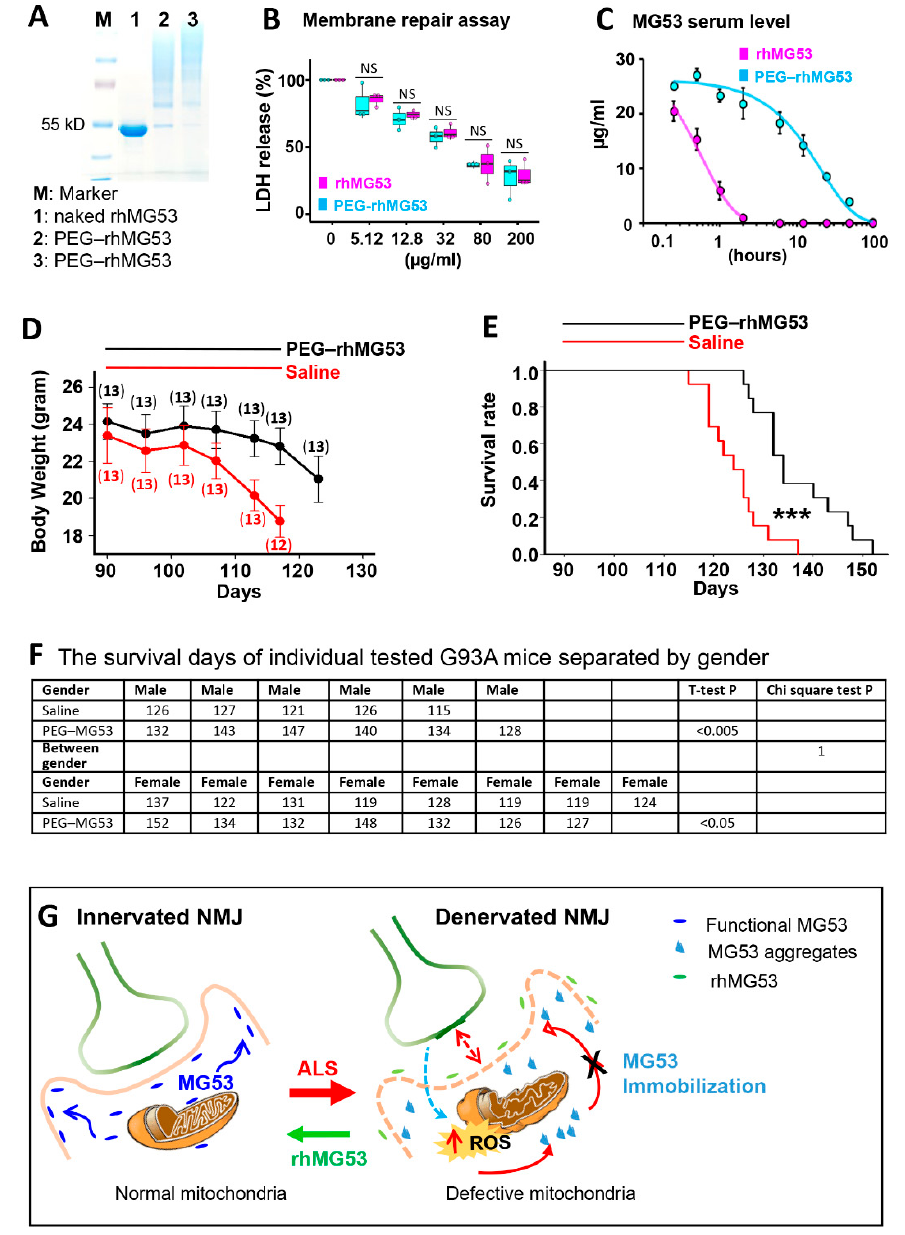
Figure 8. rhMG53 alleviates disease progression and extends the life span of G93A mice. ( A ) PEGyla- tion of rhMG53 is successful based on Coomassie blue staining of the different oligomerization pat- terns of the protein running on SDS–PAGE. Lanes 2 and 3 represent two independent rhMG53 PEGylation experiments. ( B ) The chemical modification did not affect the membrane repair function of rhM53, as there was no difference in EC 50 of LDH release from the cultured C2C12 cells following a mechanical membrane damage with glass beads between the rhMG53 and PEG–rhMG53 ( n = 3 independent experiments). ( C ) Pharmacokinetic (PK) assessment revealed that PEGylation in- creased serum half-life of rhMG53 in rats from 0.5 h (rhMG53, n = 4) to 12 h (PEG–rhMG53, n = 3). ( D ) Bodyweight changes of G93A mice receiving PEG–rhMG53 or saline treatment. The numbers of mice included in each data point are indicated on the plot. ( E ) Survival curve of G93A mice with one-month PEG–rhMG53 or saline treatment. The endpoint (death) of a G93A mouse was defined by the loss of righting reflex within 30 sec when the mouse was place on its side. ( n = 13 pairs of G93A littermates, *** p < 0.001). ( F ) The survival days of individually tested G93A mice separated by gender. The chi-square test further confirmed that the significant difference between PEG–